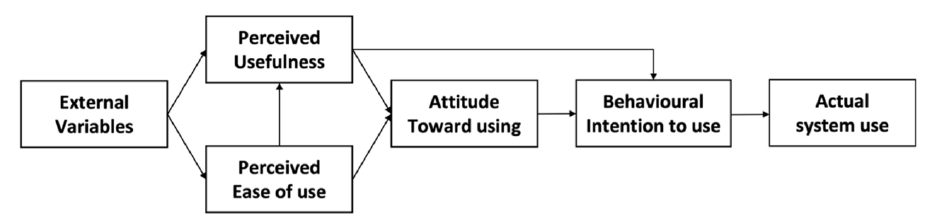
Figure 1. Technology acceptance model [54].